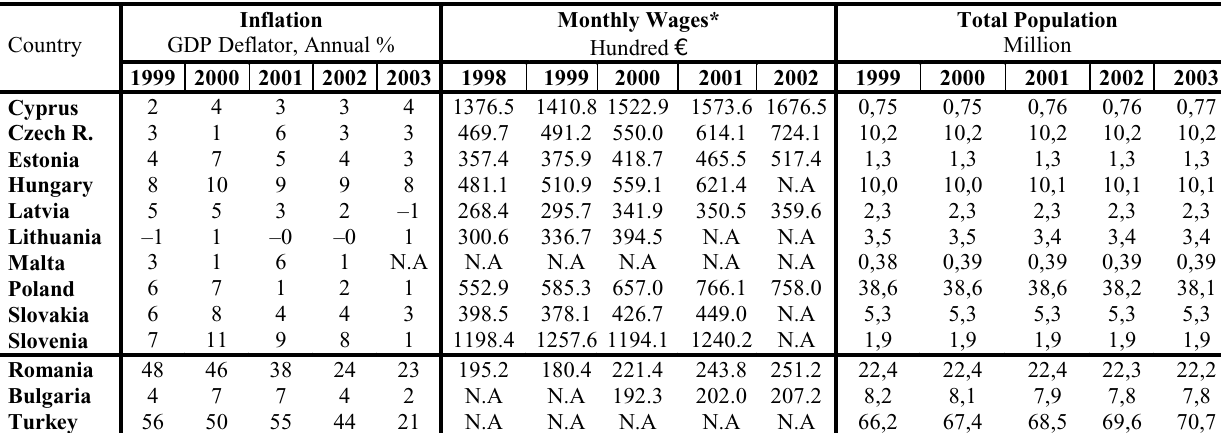
Table 9 . Comparison of Turkey with Romania, Bulgaria and the 10 new members of the EU in terms of inflation, wages and population